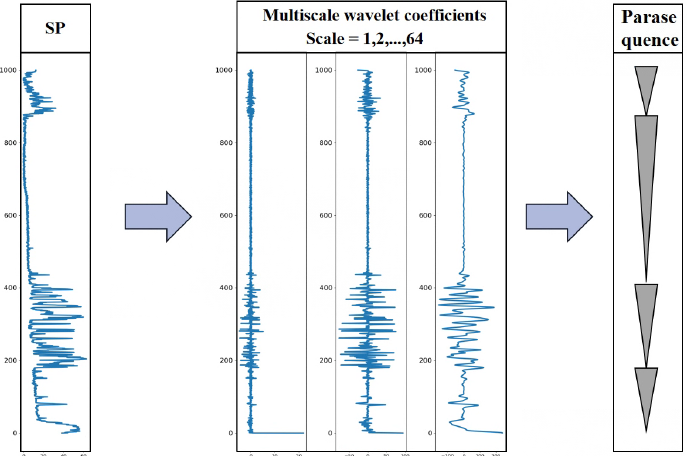
Figure 3. The process of stratigraphic division using wavelet transform. The stratigraphic division is accomplished by analyzing the wavelet coefficient curves for periodic oscillatory or modulus